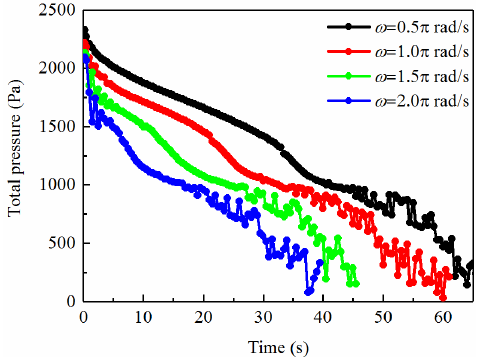
Figure 5. Total pressure variation curves at the whole drain process.